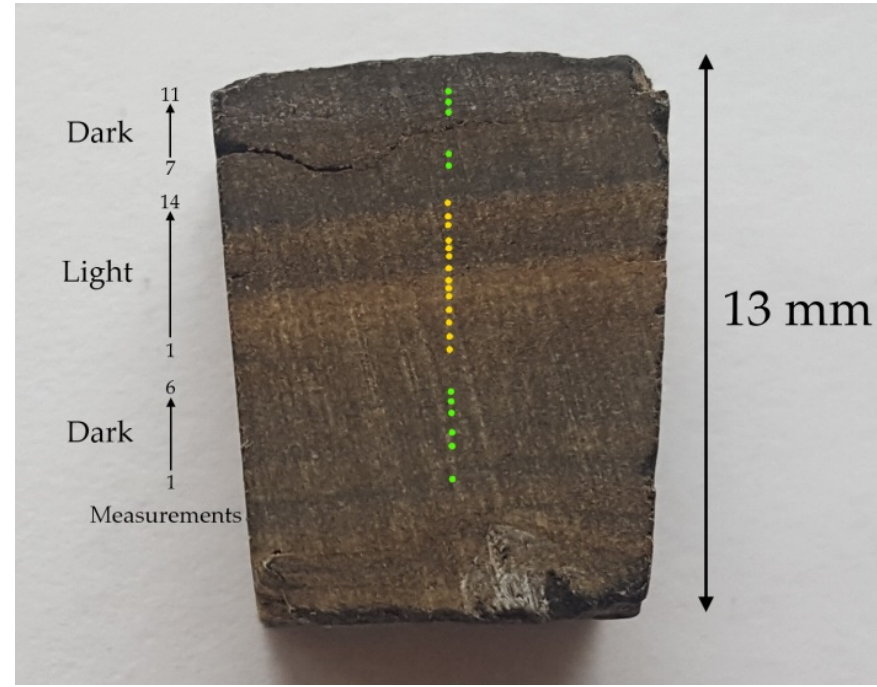
Figure 7. Photo of the Bazhenov Formation oil shale sample. Dark and light laminae, and linear measurement areas are highlighted on the images.